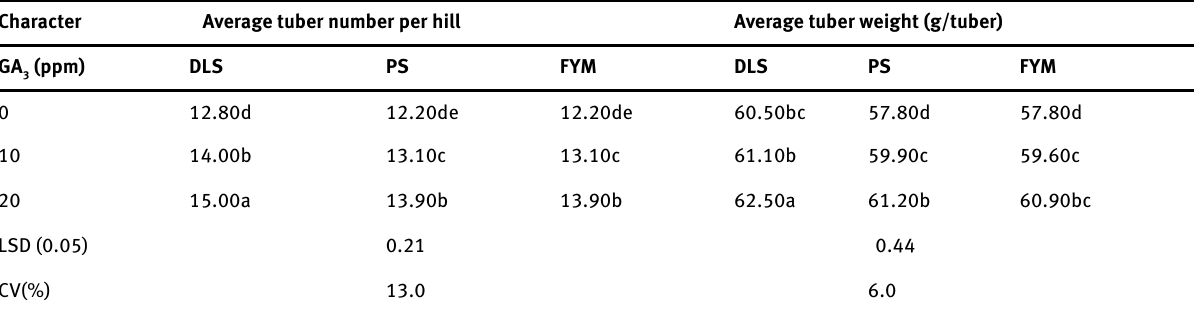
Table 5: Effects of seed tuber treatment with GA varieties grown from treated seed tube in Ethiopia